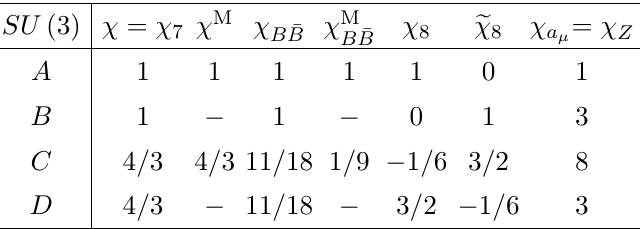
Table 2 . Table of the SU(3)-factors entering the Wilson coe(cid:14)cients for the various processes. Results are given for the four representations A-D de(cid:12)ned in eq.